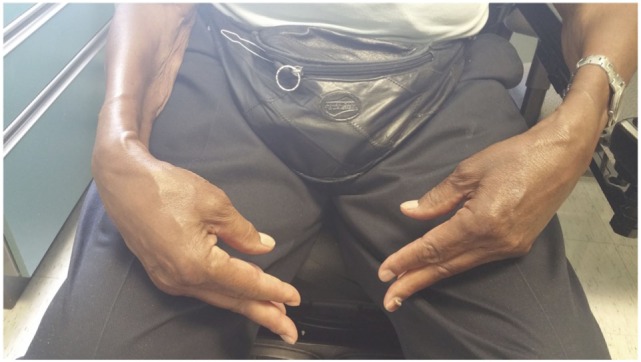
Wasting of the small muscles of the hands and forearm in sIBM.